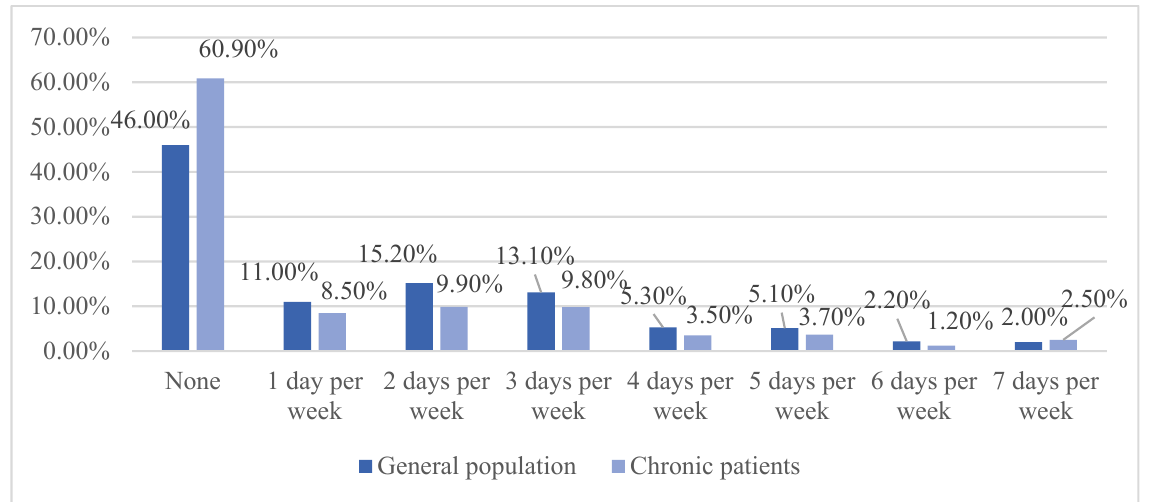
Figure 2. Differences in strength training between the general population and chronic patients. The horizontal axis represents different exercise levels, and the vertical axis represents the proportion of people with each level of exercise.